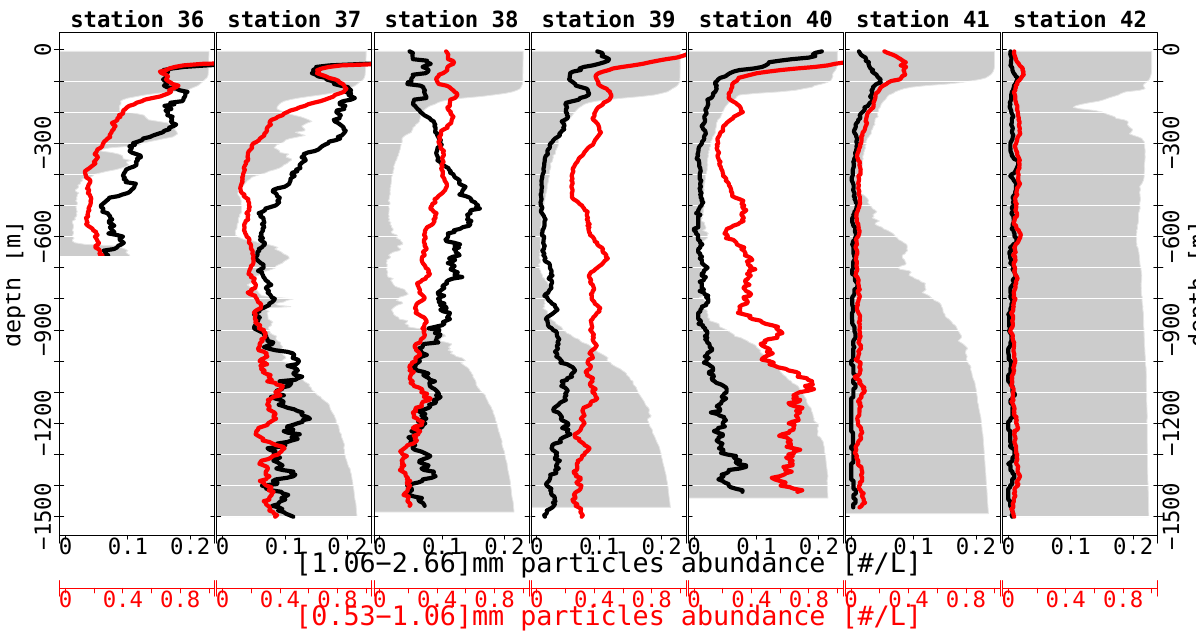
Figure 9. Vertical profiles of two size classes of particles [0.53–1.06]mm (red) and > 1.06mm (black), with oxygen concentration back- ground (grey colour, for units see Fig.